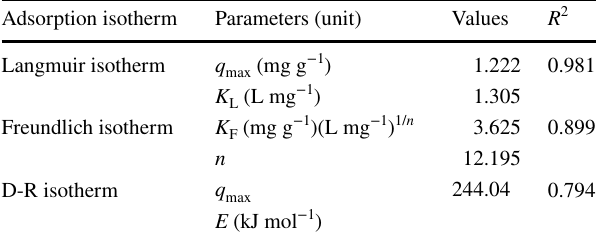
Table 3 Thermodynamic parameters for adsorption of Cr(VI)